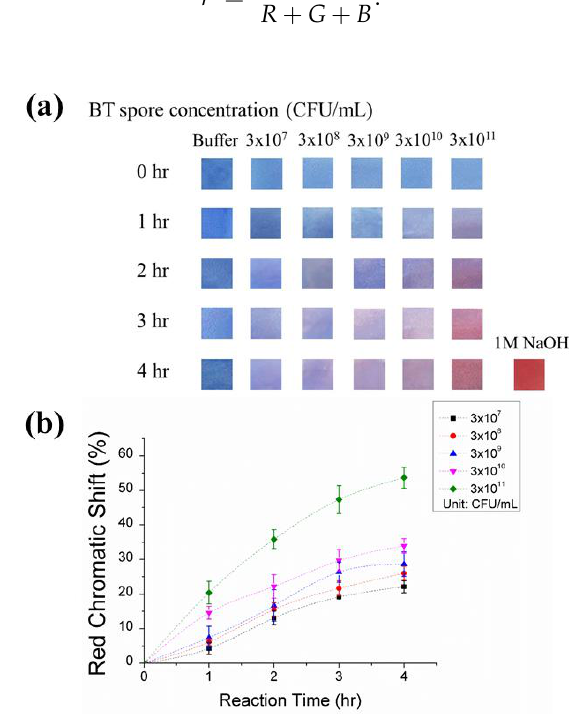
Figure 3. PDA strip detection of BT spores. ( a ) Images of the paper strips after incubation in spore solutions of different concentrations for 4 h. The negative and positive control images are from strips dipped in PBS (5 mM, pH = 7.5), and 1 M NaOH, respectively. ( b ) Red chromatic shift of the strips after 1 h, 2 h, 3 h, and 4 h of incubation in the spore solutions. Red chromatic shift data are presented as the mean ± SD (n = 3).